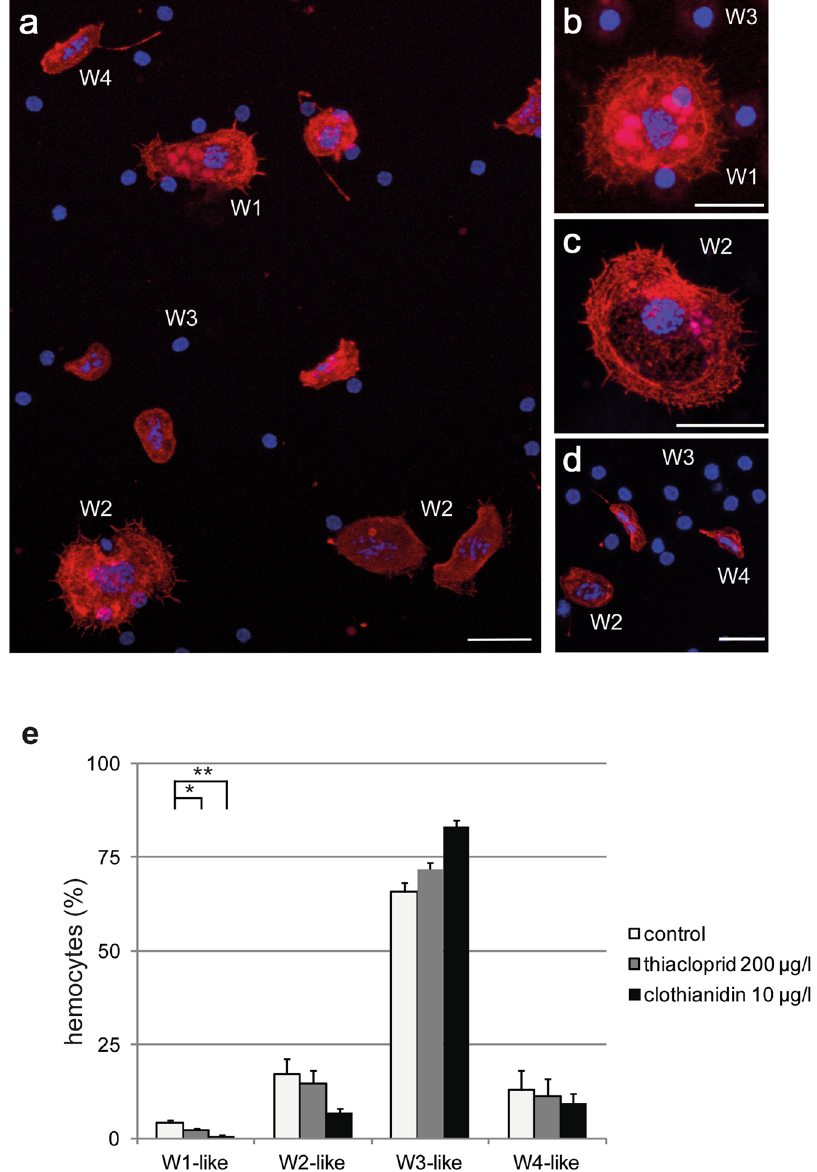
Figure 2. Exposure to neonicotinoids differentially affected hemocyte subclasses. ( a – e ) Queen hemocytes showing staining of the filamentous actin cytoskeleton (red: phalloidin-staining) and nuclear DNA (blue: DAPI- staining). ( a ) Compound image. W1-like hemocytes contained vesicle-like structures and showed extreme cellular spreading, lammelipodia formation, and filopodia-like structures with a well developed cytoskeleton marked by intensive f-actin staining ( a , b ; W1). W2-like hemocytes contained no vesicle-like structures, but also showed spreading and strong f-actin staining ( a , c; W2). The nuclei of W1- or W2-like hemocytes were large and contained decondensed chromatin. W3-like hemocytes were oval/round and had only very weak f-actin staining. Nuclear chromatin of W3 like cells was highly condensed ( a , b , d ; W3). W4-like hemocytes had a spindle-shaped morphology and showed intensive f-actin staining of the cytoskeleton and elongated nuclei ( a , d ; W4). ( e ) Thiacloprid (200 µ g/l) or clothianidin (10 µ g/l) treatment affected the composition of the hemocyte population (8 to 9 individuals per treatment group, at least 350 cells per individual counted). Thiacloprid or clothianidin exposure significantly reduced the number of W1-type hemocytes. Clothianidin treated queens had a lower percentage of W2-like cells and a higher percentage of W3-like cells compared to control queens (error bars = s.e.m; * p ≤ 0.05; ** p ≤ 0.01; scale bar 10 µ